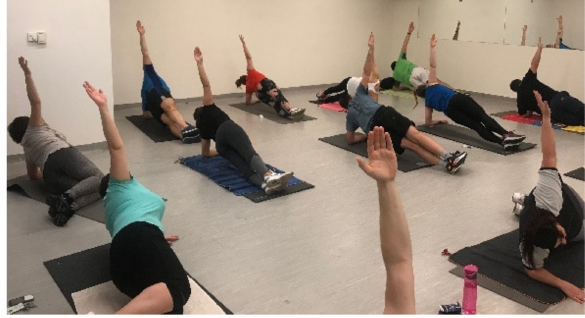
Figure 4. Segmental stabilization in side bridging.